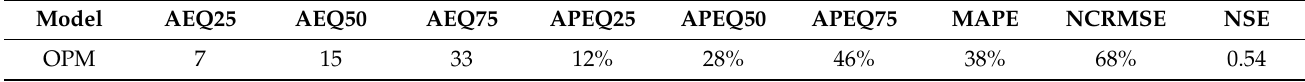
Table 2. OPM evaluation results.